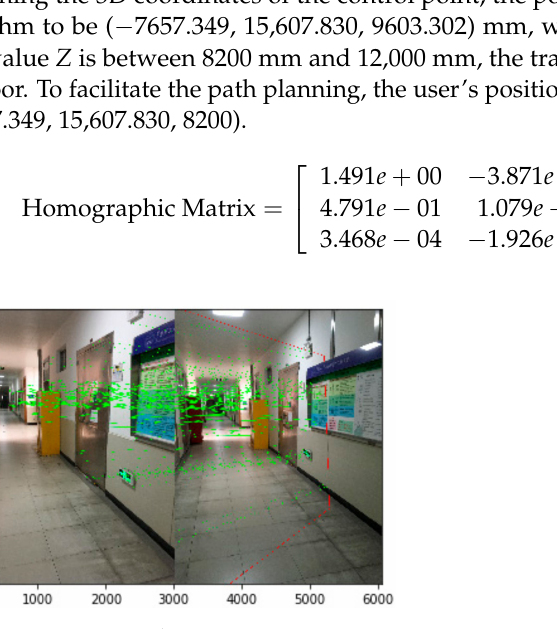
Figure 15. Feature matching. Table 4. Pixel coordinates after